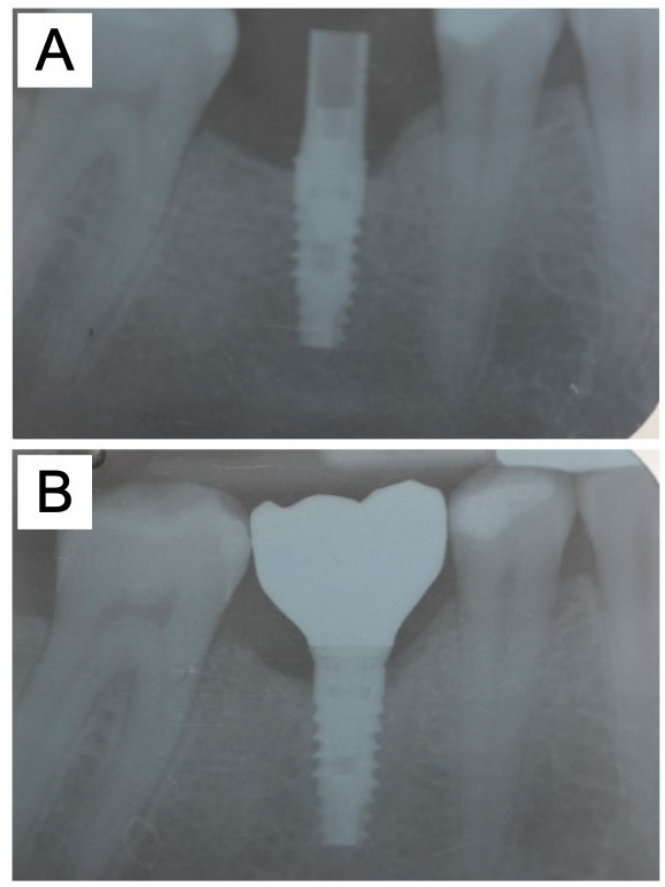
Figure 18. Radiographic verification of the correct coupling between the implant and prosthetic components. ( A ) Temporary prosthesis. ( B ) Final single crown.